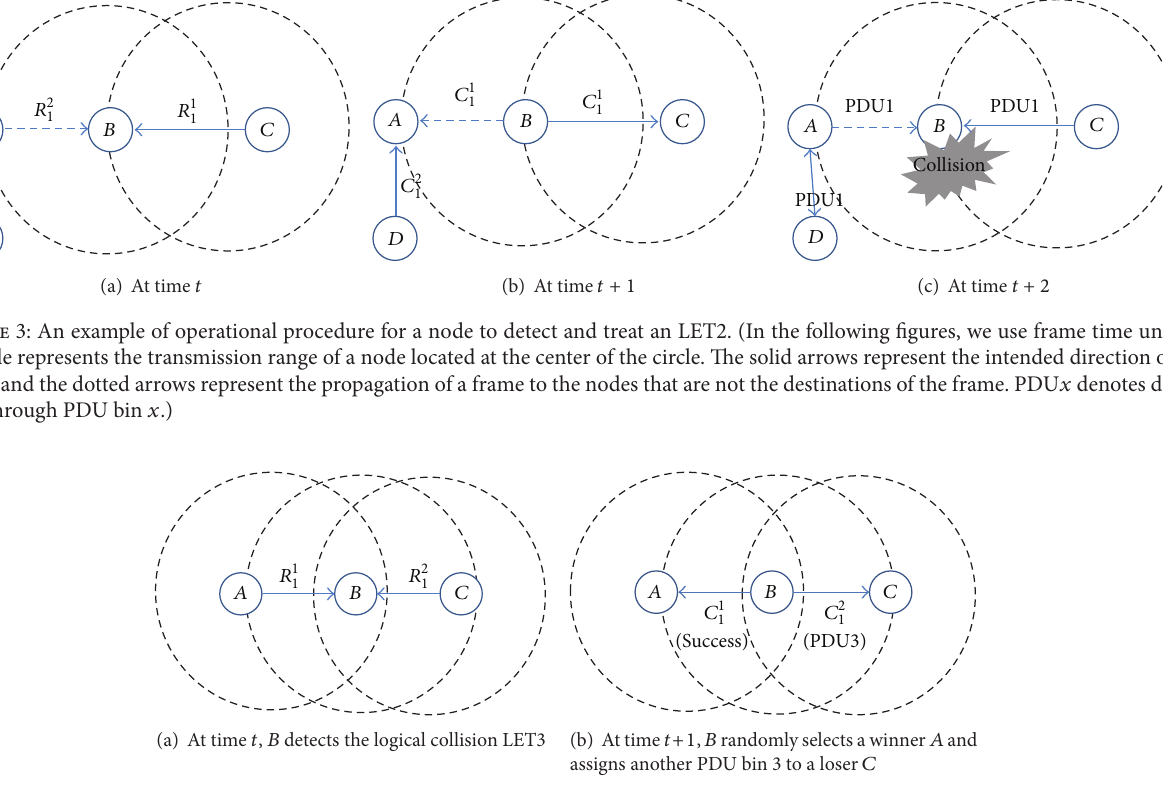
Figure 4: An example of operational procedure to detect and treat an LET3. (When 𝐵 detects an LET3, 𝐵 randomly selects a winner and informs the winner of the successful reservation. 𝐵 sends a 𝐶 2 1 to 𝐶 with another PDU bin 3 that is not in 𝑈 𝐵